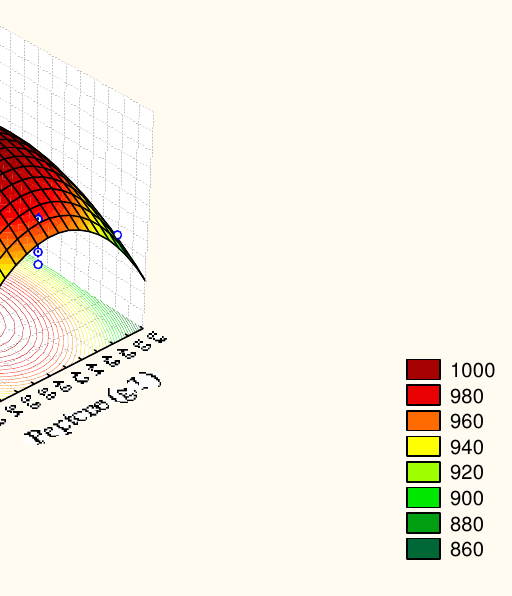
Figure 3( e). Effect of peptone & pH on protease activity